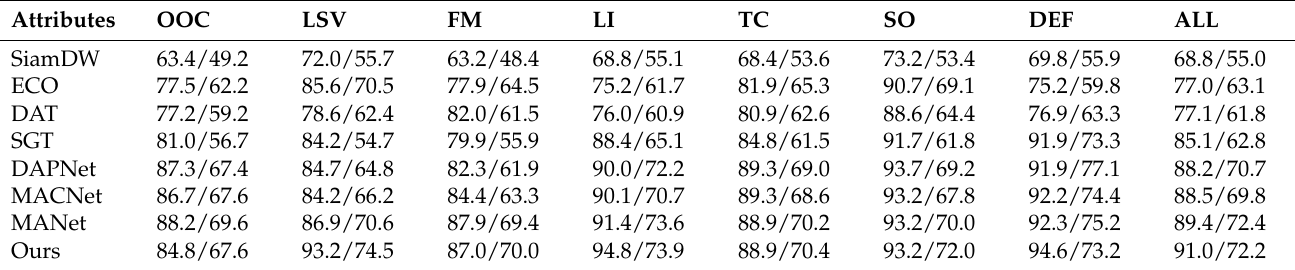
Table 1. Attribute-based accuracy and success rate (PR/SR) is obtained by using different trackers on the GTOT dataset. Red, green, and blue numbers represent the best one, the second-best one, and the third-best one, respectively.